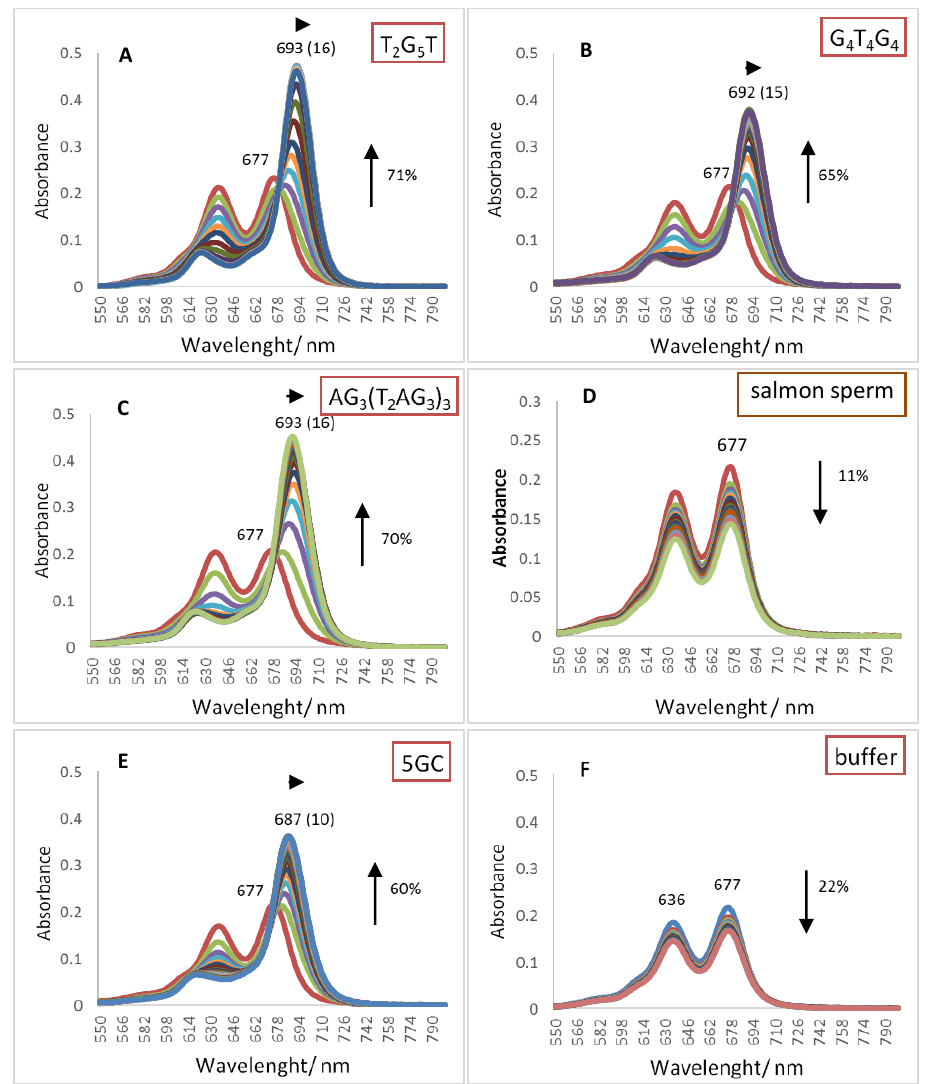
Figure 6. UV-Vis absorption spectra (550−800 nm) for the titrated solutions of ZnPc4 (2.0 μM) with ( A ) tetramolecular GQ, ( B ) bimolecular GQ, ( C ) unimolecular GQ, ( D ) salmon sperm, ( E ) 5GC, and ( F ) 20 mM PBS buffer with 100 mM KCl.